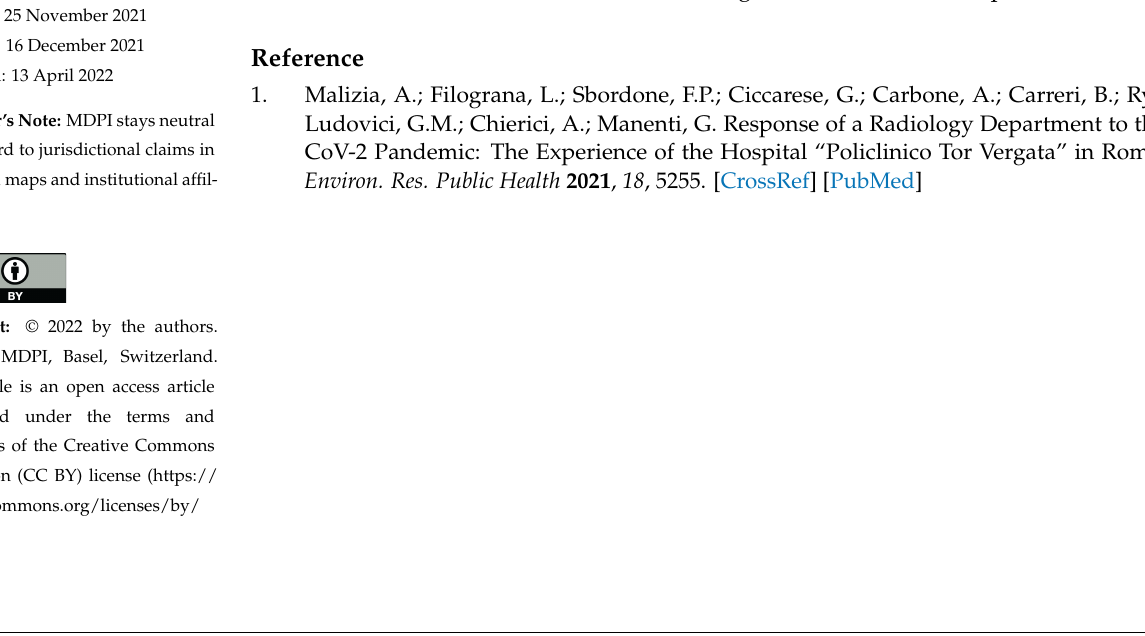
Figure 3: This image represents the PPE used before the pandemic situation; the actual PPE is different, so the image has to be